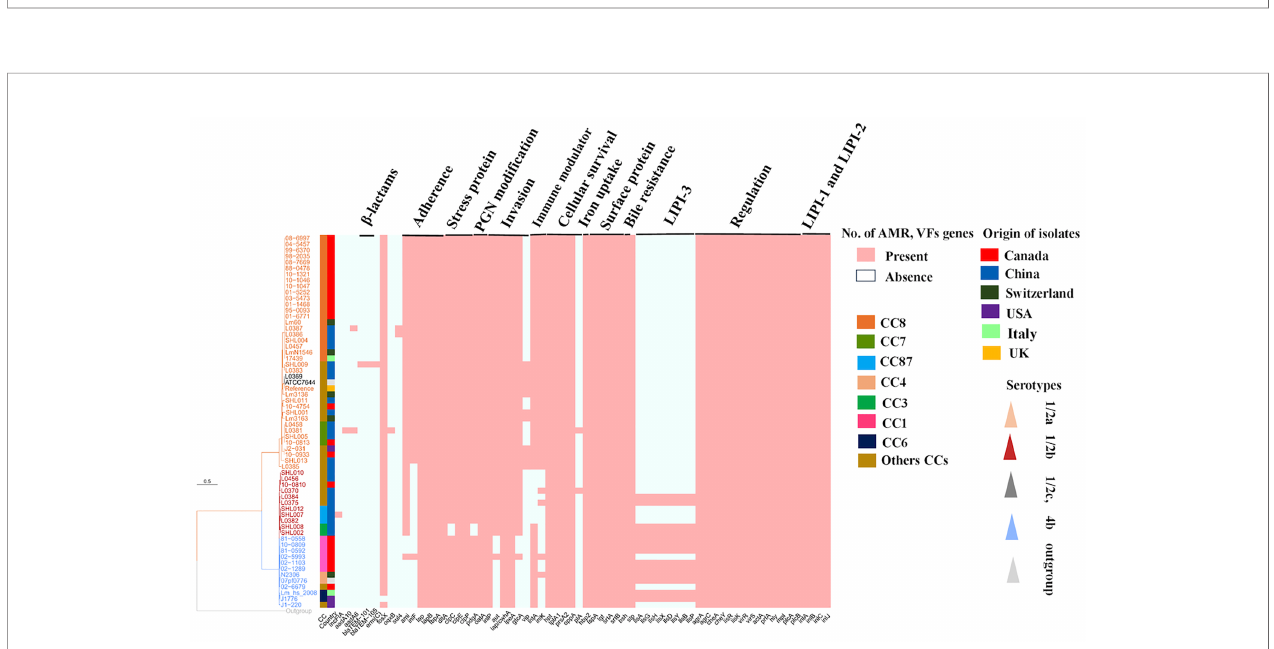
FIGURE 4 | Phylogenomic analysis and heat map composition of antibiotic resistance genes (ARGs) and virulence factors (VFs) of worldwide Listeria monocytogenes clinical isolates. There are 60 isolates from different countries including China, Canada, Switzerland, USA, and Italy. Here, 139,505 single-nucleotide polymorphisms (SNPs) were used to construct the maximum likelihood phylogenomic tree for all compared genomes. EGD-e (reference strain), ATCC7644 (control strain), Listeria inoccua -CFSAN044836 (out-group strain). Tree scale represents the genetic distance between the isolates used to construct the tree. On the right, there is a heat map about pathogenic composition with clonal complexes (CCs); Plasmid: ( incFIA_1 ); ARGs: aminoglycosides: aadA10_2, aadA6_1 ; b -lactams: bla TEM-101 , bla TEM-105 ; macrolide: ermC-15 ; fosfomycin: fosX_2 ; quinolones: oqx_1 ; sulfonamide: sul4_1 ; Adherence genes: dltA , ami , inlF, iap, iapB, fbpA ; stress- related genes: clpC, clpE, clpP ; peptidoglycan modi fi cation genes: pdgA, oatA ; invasion genes: inlP, aut, iap/cwhA, iapB, ipeA, gtc, vip ; immune modulator genes: lntA, inlK ; intracellular survival genes: hpt, ipIA, prsA2, oppA, pIA ; iron uptake genes: hbp2 ; surface protein-anchoring genes: IspA , Igt, srtA, srtB ; bile resistance genes: bsh ; enzymatic genes: stp ; listeriolysin S (LLS) toxin (LIPI-3): llsA, llsG, llsH, llsX, llsD, llsY, llSB, llsP ; regulation genes, agrA, agrC, cheA, cheY, lisR, lisK, virR, virS ; Listeria pathogenicity islands-1 (LIPI-1) genes: actA, prfA, hly, mpl, plcA, plcB ; Listeria pathogenicity islands-2 (LIPI-2) genes: inlA, inlB, inlC, inlJ .